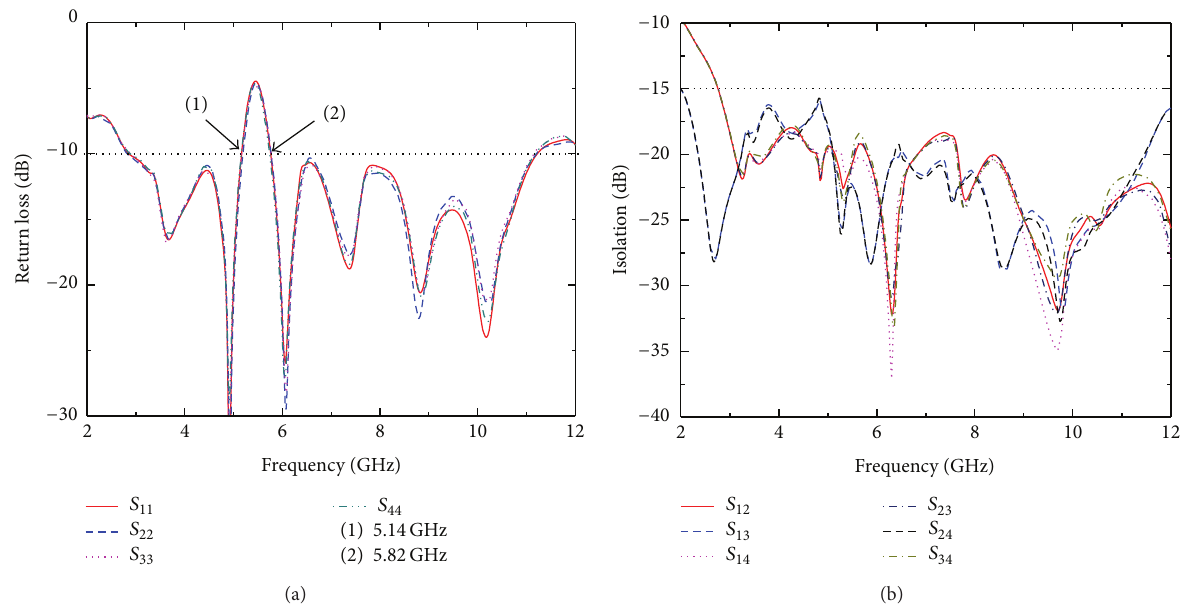
Figure 16: Simulated results of the final MIMO antenna: (a) return loss and (b) isolation coefficient.